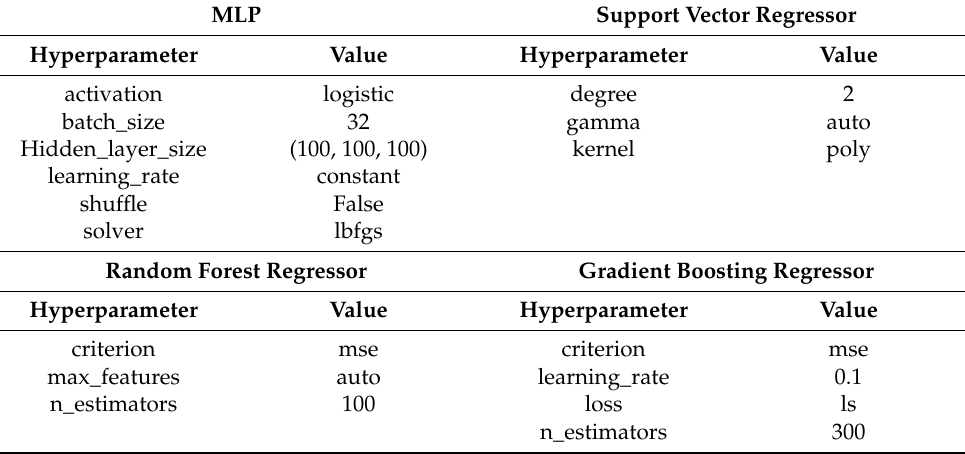
Table 9. Hyperparameters for baseline